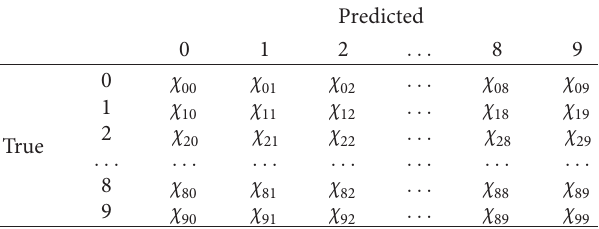
Table 4: Confusion matrix of ten-class classification.